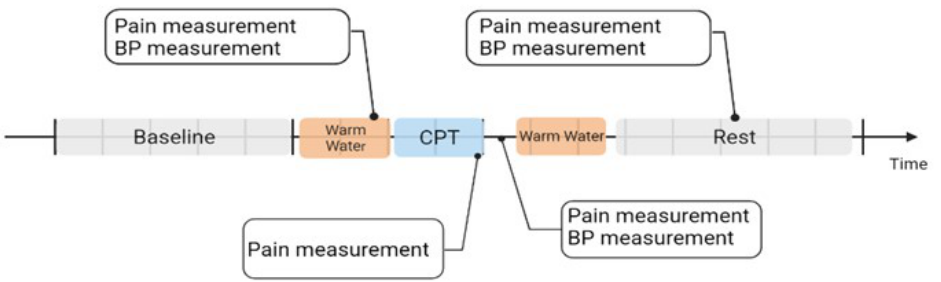
Figure 2. Representation of the different steps of the experimental procedure, with further indication of the moments where pain was self-reported and the BP measured. ECG, EDA, and EMG were continuously recorded throughout the